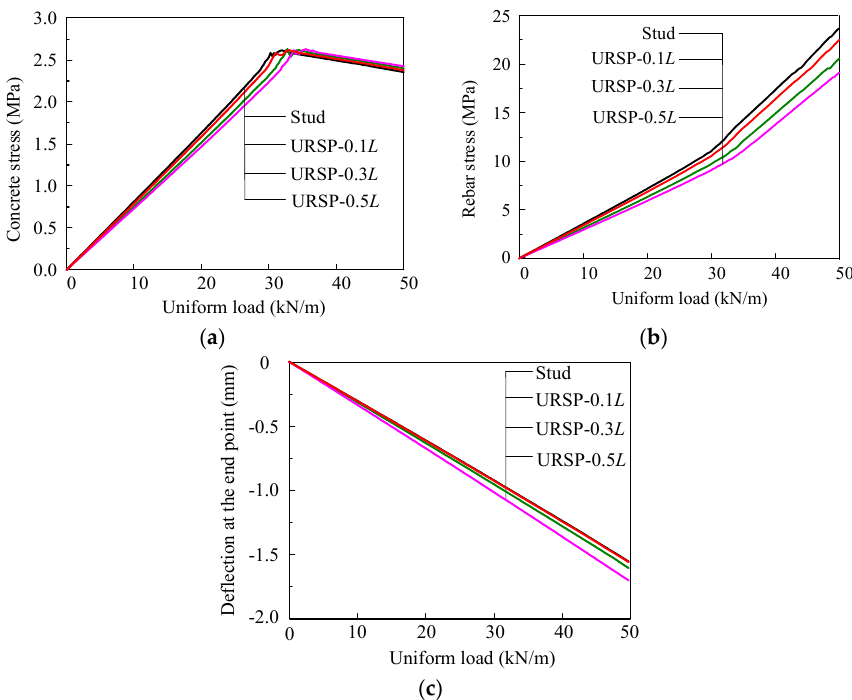
Figure 18. Results of models subjected to vertical loads. ( a ) Concrete stress; ( b ) rebar stress; ( c ) Figure18. Resultsofmodelssubjectedtoverticalloads. ( a )Concretestress; ( b )rebarstress; ( c deflection.